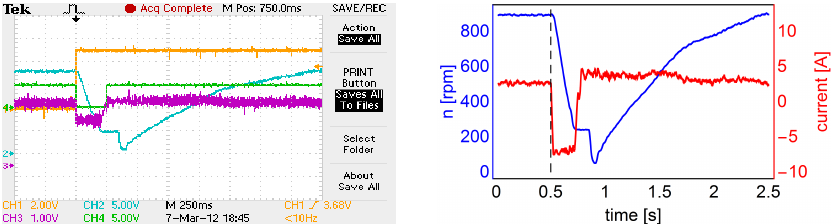
Figure 25. Oscillogram ( left picture) shows the spin direction signal in orange, the spin direction signal in green, the recorded speed signal in blue, the motor current in purple, while the graph ( right picture) shows the speed (blue line) and motor current (red line) and the dashed line indicates the start of a motor